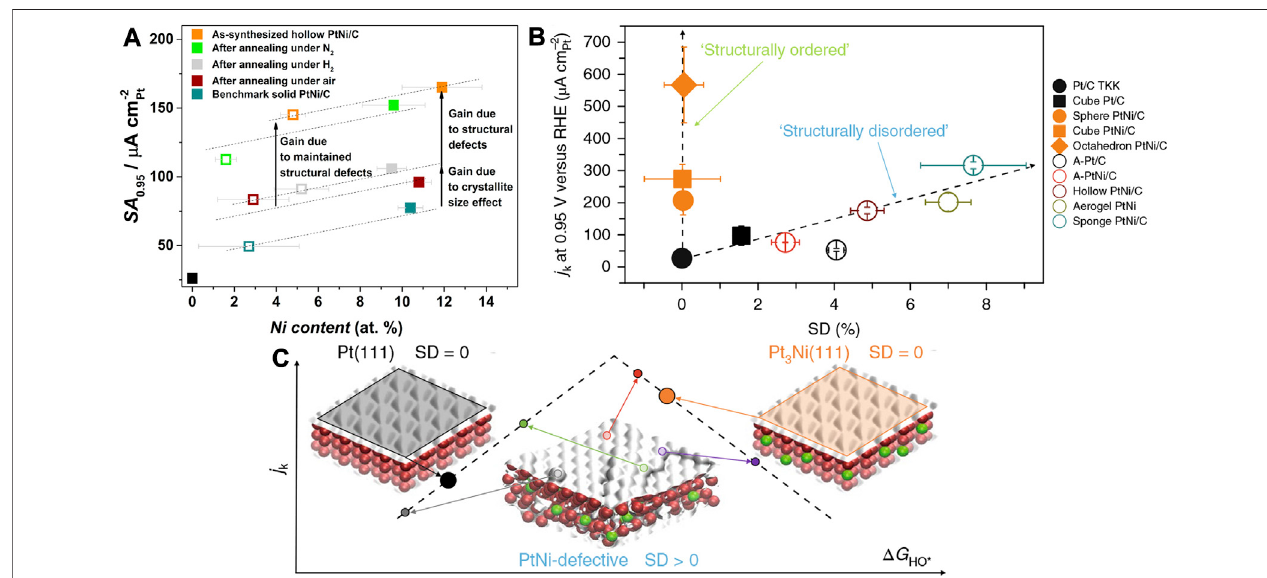
FIGURE 15 | (A) SAs of hollow PtNi nanoparticles under different annealing atmospheres, solid and hollow squares represent the activity before and after the stabilitytest, respectively. (B) Active current ofnanoparticles with different SD(surface distortion). (C) Illustrationof j k - Δ G HO* relation oftwo strategies toimproveintrinsic activity,byhomogenizingthesurfaceandintroducingdefects onthesurface. (A) Reproduced withpermission (Dubauet al.,2017).Copyright2017,AmericanChemical Society. (B,C) Reproduced with permission (Chattot et al., 2018). Copyright 2018, Springer Nature.